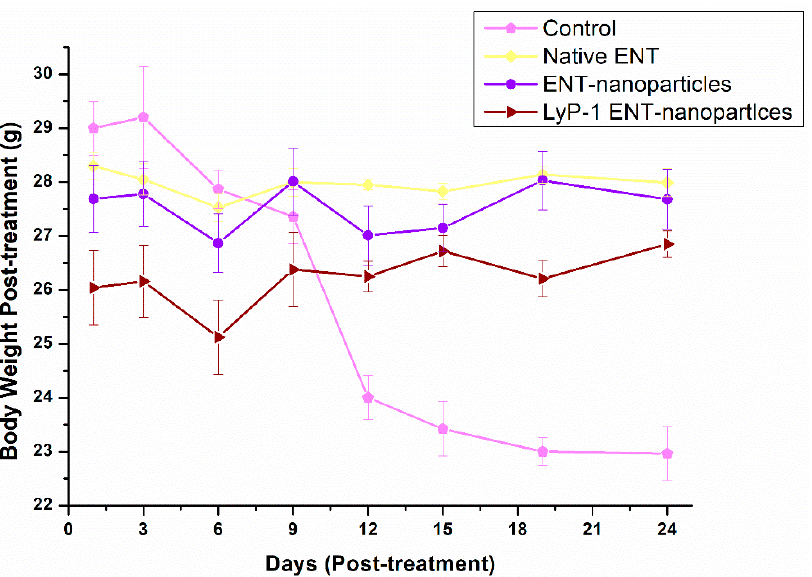
Figure 11. Variation in body mass of the mice over the 24-day study period. Error bars indicate ± standard deviation.